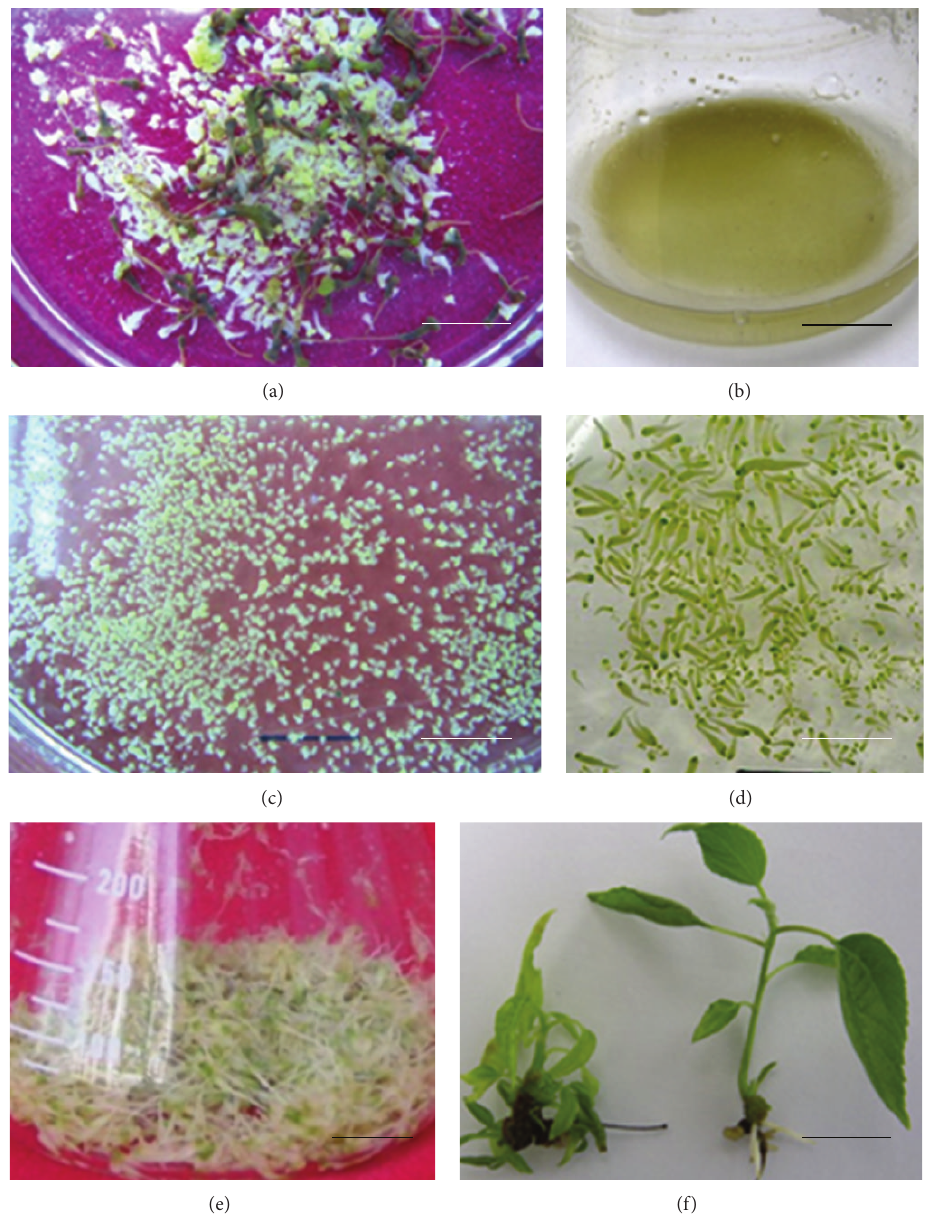
Figure 2: Cyclic somatic embryogenesis from germinated SEs on liquid medium. (a) Secondary SEs (bright white) induced directly from primary germinated SEs (black) in liquid medium 4 weeks after being cultured in MS liquid medium without PGRs. (b) Collected embryogeniccellclumpsinducedfromgerminatedSEsinliquidmedium.(c)Numerousheart-shapedSEswhichdevelopedafterembryogenic calluses were cultured in MS liquid medium without PGRs for 6 weeks. (d) Cotyledonary SEs after embryogenic calluses were cultured in liquid medium for 8 weeks. (e) Germinated SEs after embryogenic calluses were cultured in liquid medium for 10 weeks. (f) Plantlets from germinated SEs on agar medium. Bars = 10mm (a), 15mm (b), 10mm (c), 10mm (d), 15mm (e), and 10mm